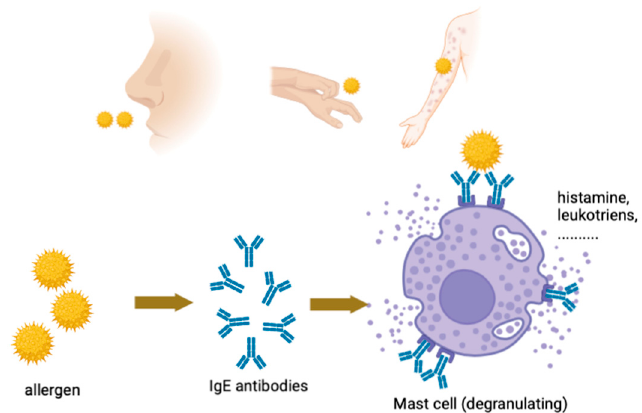
Figure 5. Mechanism of allergy. When allergens invade the body for the first time, specific antibody immunoglobulin E. (IgE) is produced in the body. Then, the IgE binds to mast cells, resulting in releasing chemical mediators such as histamine, leukotrienes, after exposure to the allergens for the second time. Created with BioRender.com.